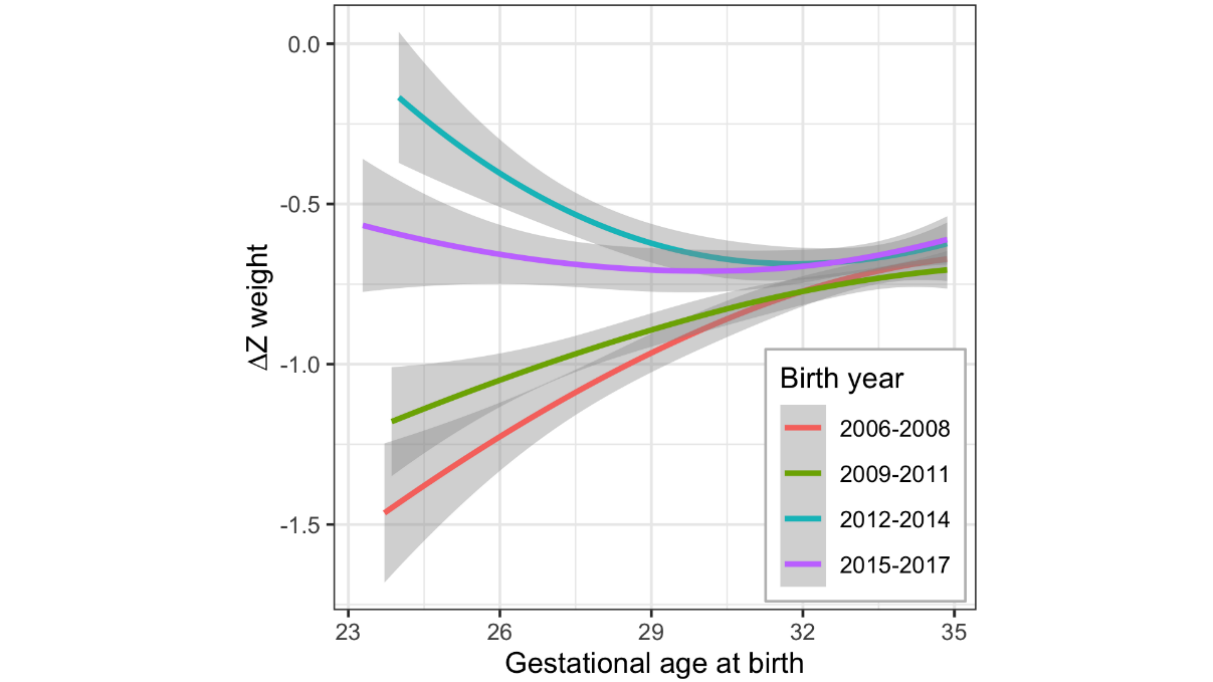
Figure 7. Improvement of growth outcomes ( ∆ Z weight) at hospital C, by birth gestation and birth year epoch. Epoch 2006 – 2008 is pre-intervention; 2009 - 2011 covers the beginning of implementation of interventions; 2012 - 2014 is the immediate post-intervention epoch; 2015 - 2017 demonstrates sustained improvement, but less extreme at lower gestational ages, after targeting a goal ∆ Z weight of -0.6. The largest improvements are seen at the lowest gestational ages at